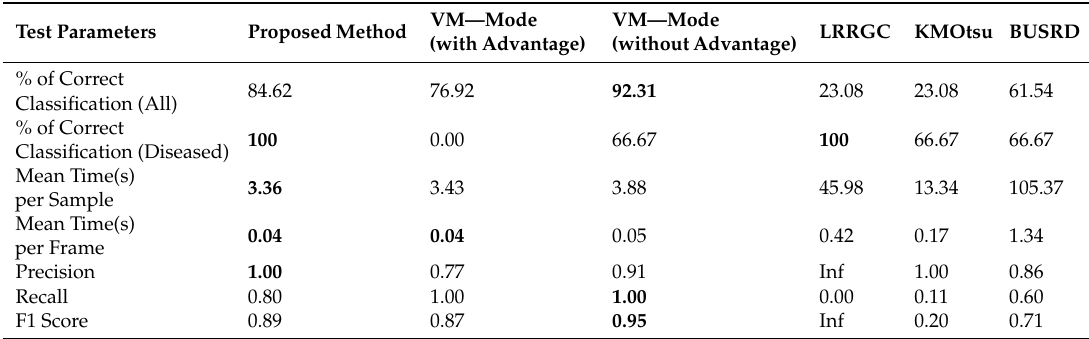
Table 2. Performance Comparison between Proposed method, VM-Mode [15], LRRGC [16], KMOtsu [29] and BUSRD [30] for the second dataset (bold indicates best